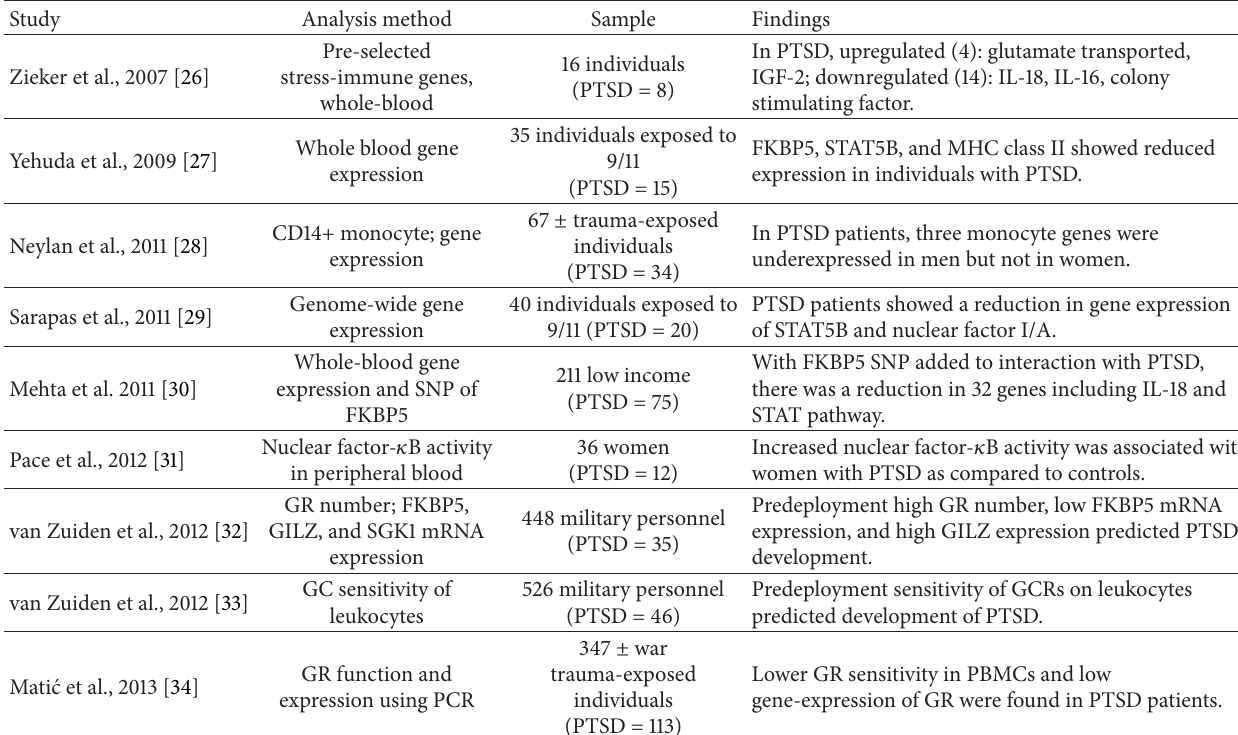
Table 2: Gene expression studies.